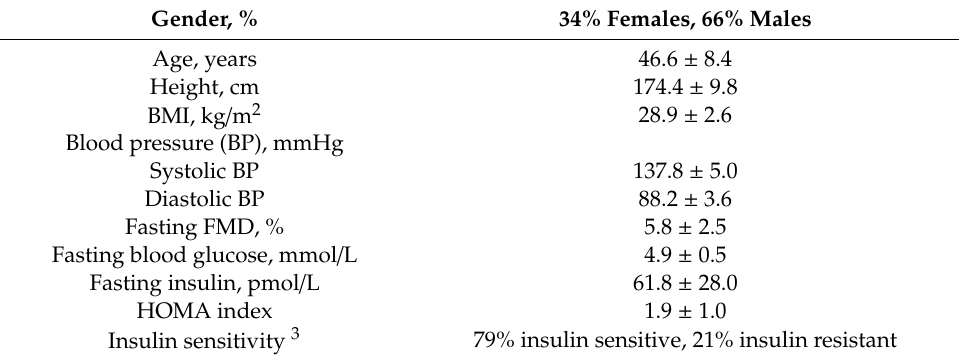
Table 1. Baseline characteristics of the study population before the first intervention day (n = 78). 1,2